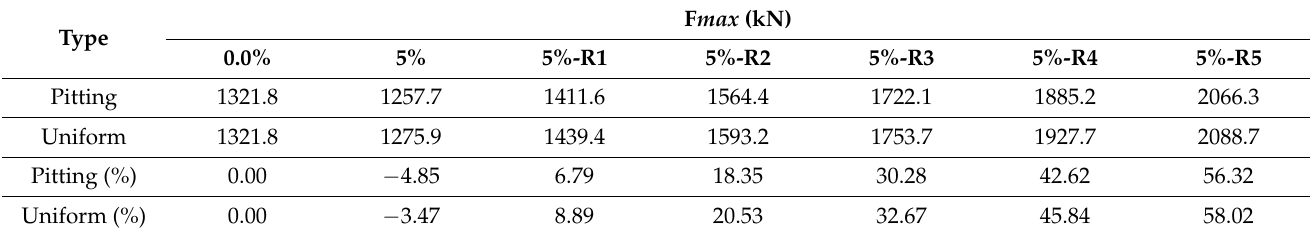
Figure 5. Skeleton curves for a bridge pier with uniform corrosion. ( a ) 5%, ( b ) 10%, ( c ) 15%, ( d ) 20%. Table 2. Peak force of a bridge pier with 5% corrosion under different thicknesses of steel plates.